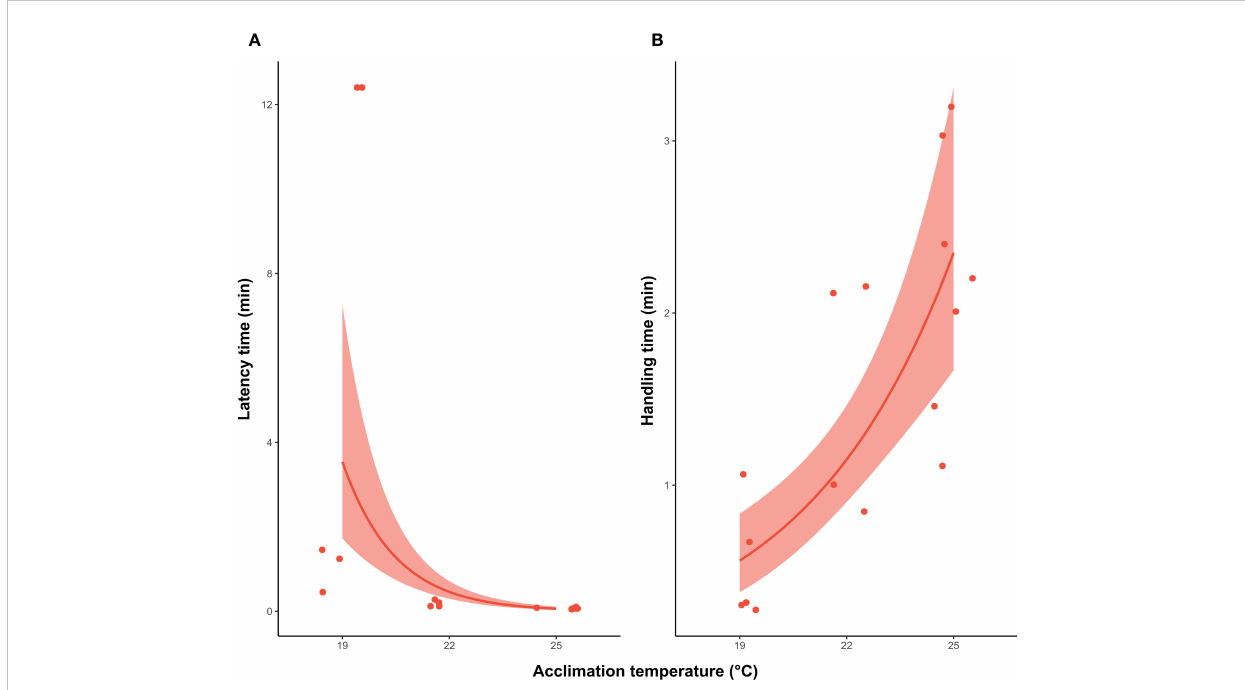
FIGURE 4 Southern calamari ( Sepioteuthis australis ) which successfully attack prey at different temperatures of acclimation (19, 22 and 25°C). (A) GLM model with a gamma distribution of latency time (min) that squid took to make the fi rst attack (B) GLM with a gamma distribution of the handling time (min) to capture and kill the prey. Thick line represents the expected value from the model for the variable measure. The shadow band corresponds to the 95% con fi dence interval, and the individual values are represented by the red